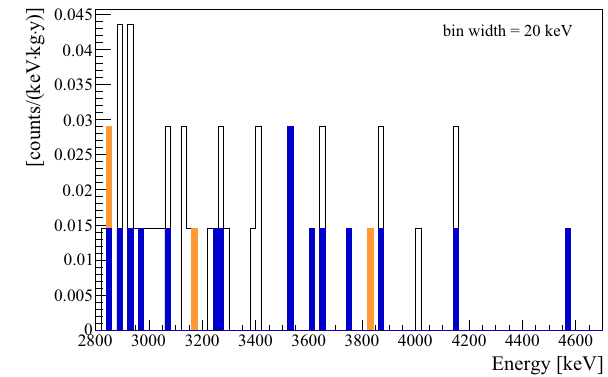
Fig. 10 Open histogram: high-energy β / γ spectrum of CUPID-0 obtained with a ZnSe exposure of 3.44kg · y. Orange: the same spec- trum after applying a time-veto of 3 half-lives after the detection of an α particle with energy compatible with the Q-value of 212 Bi. Blue: events that survive a time-veto of 3 half-lives after the detection of an α particle with energy larger than 2MeV